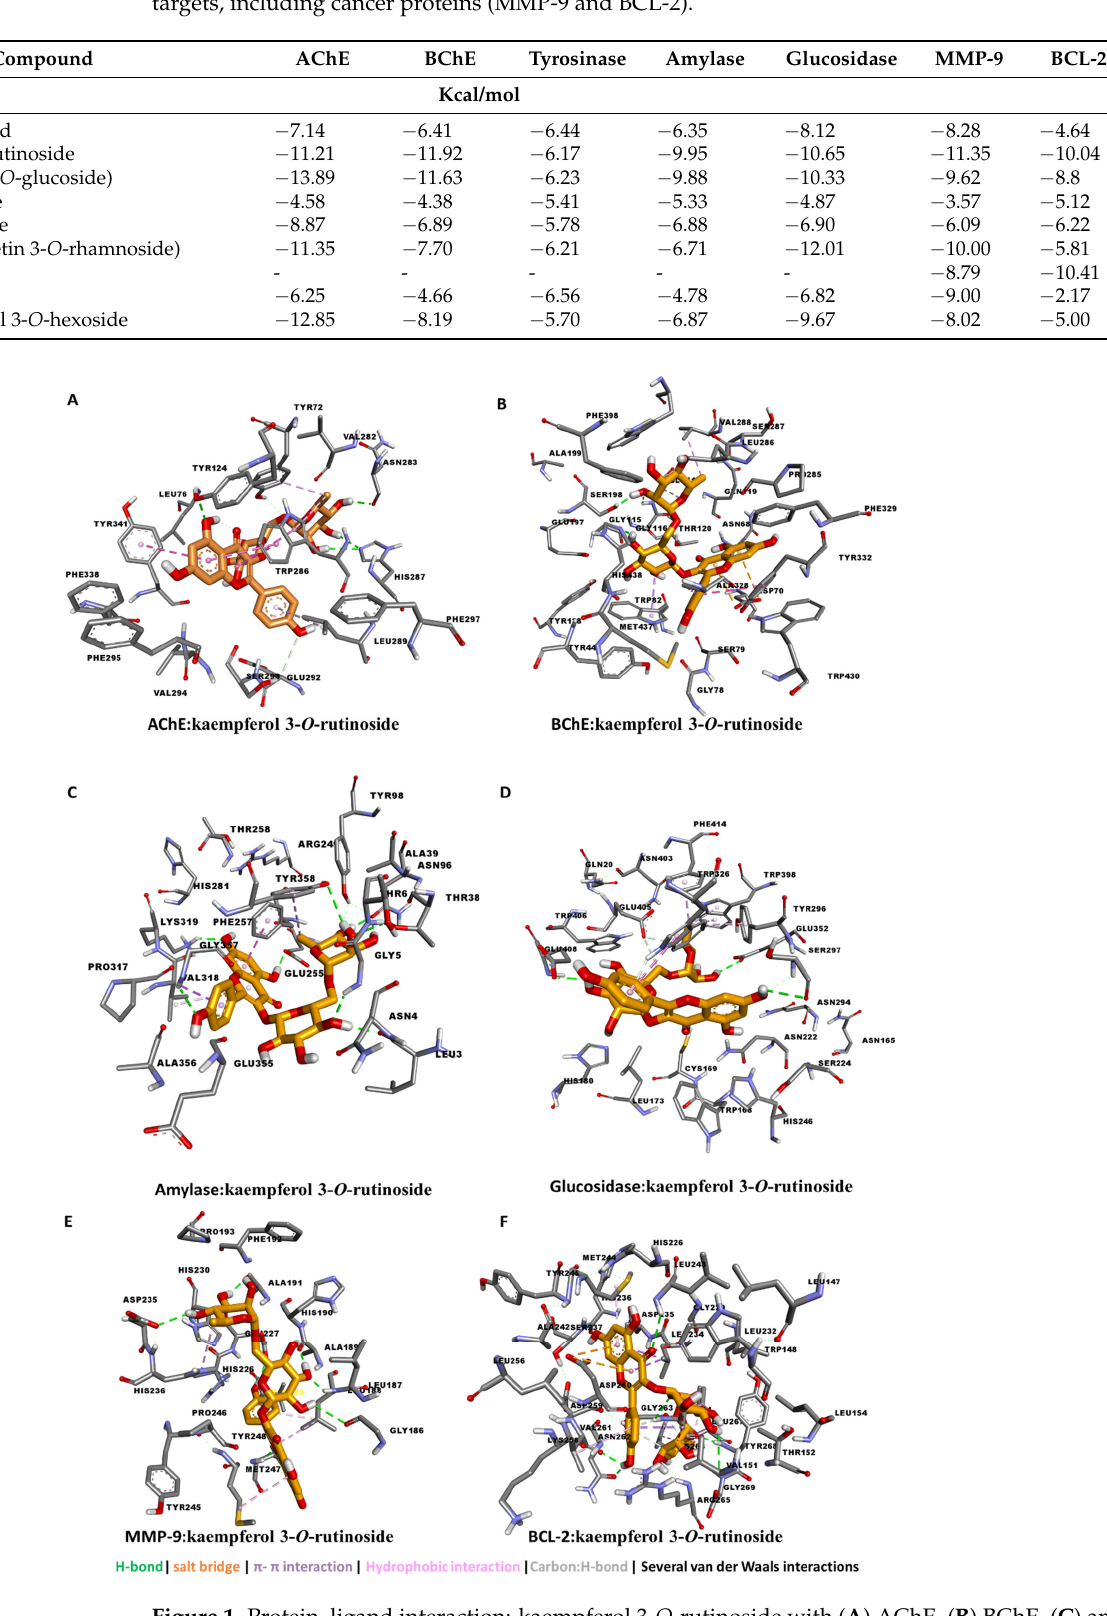
Figure 1. Protein–ligand interaction: kaempferol 3- O -rutinoside with ( A ) AChE, ( B ) BChE, ( C ) amylase, ( D ) glucosidase, ( E ) MMP-9, and ( F ) BCL-2.